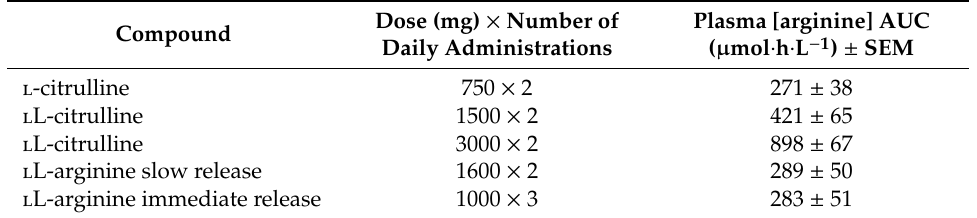
Table 1. Plasma l -arginine area under the curve (AUC) after 1 week of di ff erent l -citrulline and l -arginine dosing regiments Table 1. Plasma L -arginine area under the curve (AUC) after 1 week of different L -citrulline and L - arginine dosing regiments [6] .